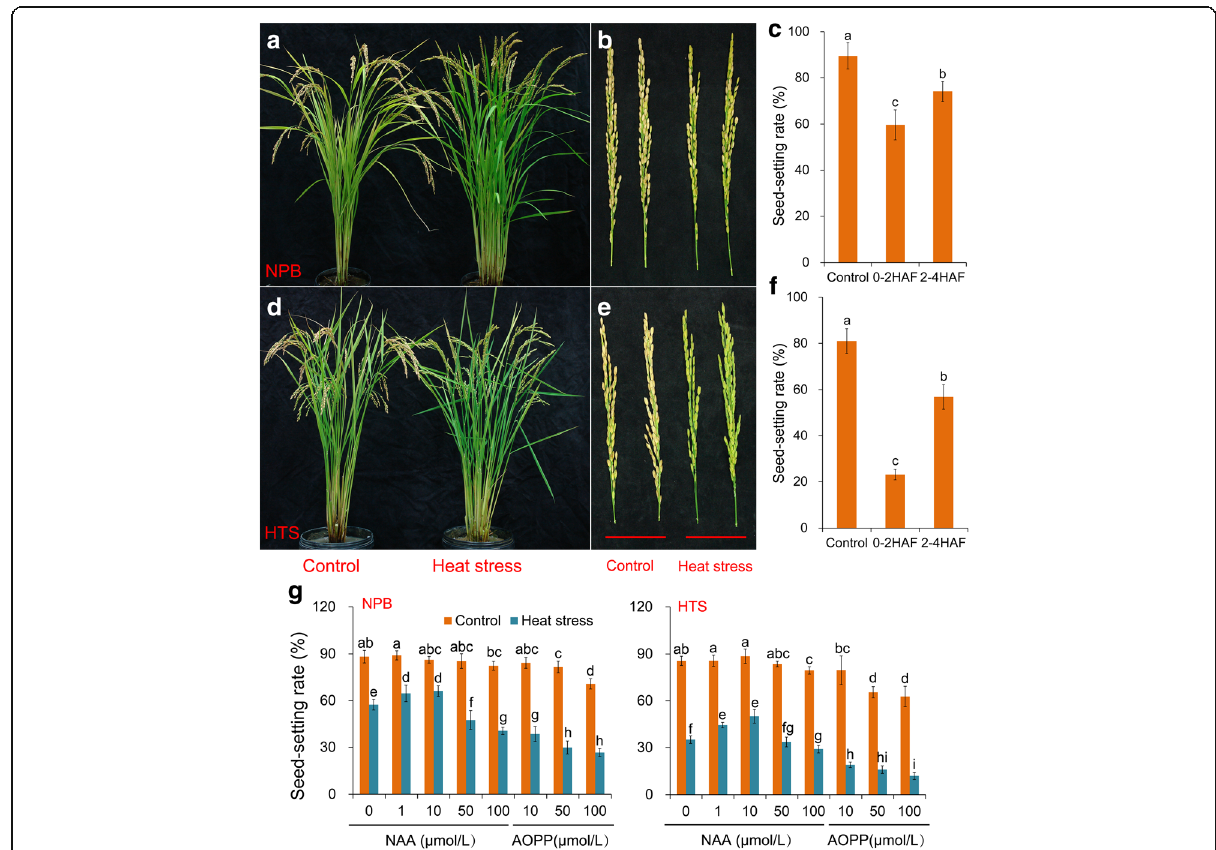
Fig. 1 Effect of heat stress on the spikelet fertility of rice plants at the flowering stage. a , b , d and e show rice plants with spikelets exposed to heat stress for 10 d at flowering stage. c and f show the response of spikelet fertility to heat stress at different flowering time period. HAF is hours after flowering. 0 – 2 HAF, means that the flowering spikelets were immediately subjected to heat stress for 2 h; 2 – 4 HAF, means that rice plants were subjected in heat stress for 2 h during 2 – 4 h after flowering. g shows the effect of NAA and AOPP on the spikelet fertility of rice plants under heat stress at the flowering stage. Different NAA and AOPP levels were sprayed onto the flowering spikelets before heat stress. Different letters within the same column indicate statistically significant differences between different treatments in the same cultivar ( n =3) ( P